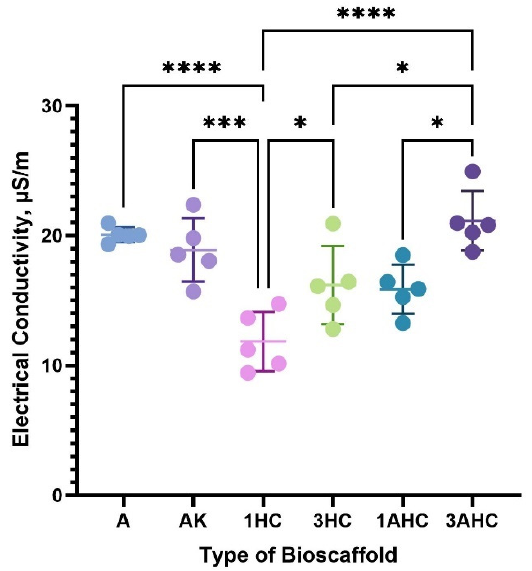
Figure 10. Electrical conductivity results of bioscaffolds. The 3AHC bioscaffold showed the highest electrical conductivity among the fabricated bioscaffolds. The statistical significance was considered at a probability of p < 0.05 (* p = ≤ 0.05, *** p = ≤ 0.001, **** p = ≤ 0.0001).